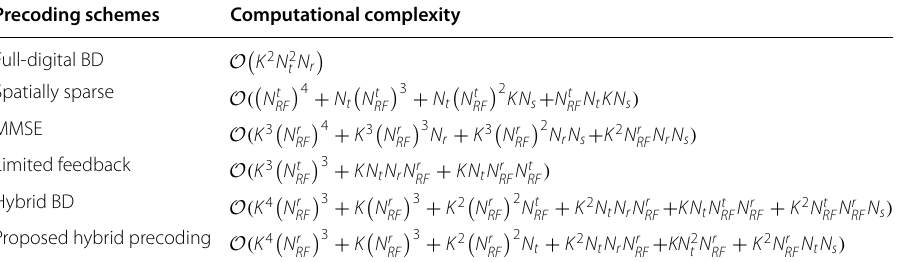
Table 1 Computational complexity Precoding schemes Computational complexity Full-digital